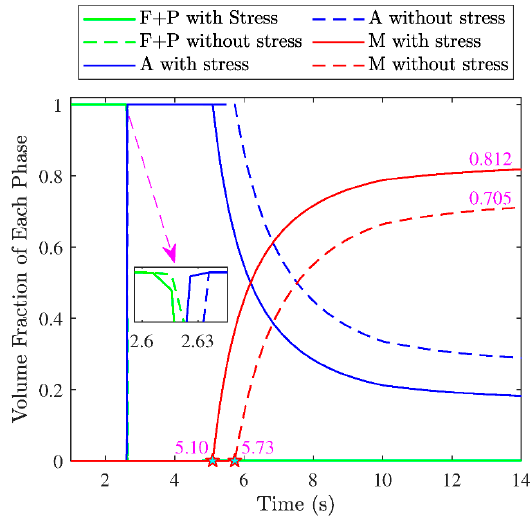
Figure 12. Effect of stress on the evolution of each phase.